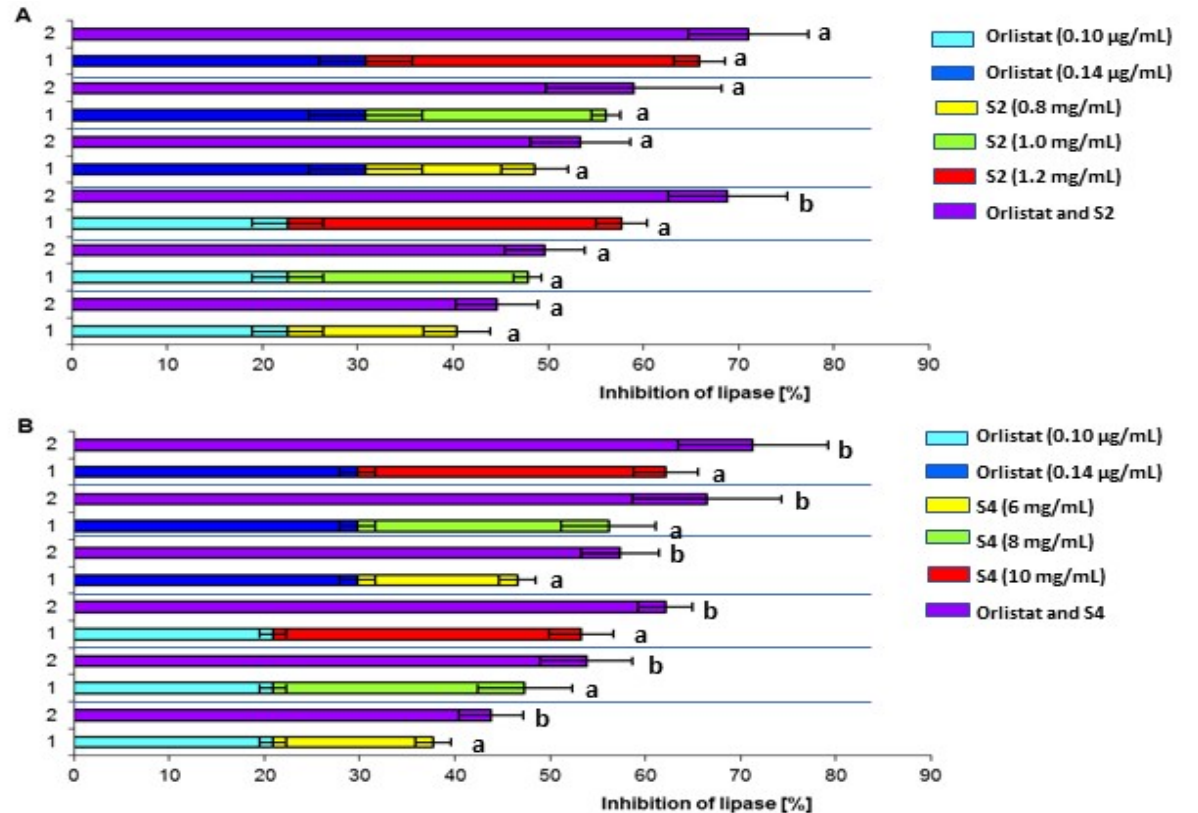
Figure 1. Percentage lipase inhibition by unripe fruits (S2) and orlistat (O)—( A ), and ripe fruits (S4) and orlistat—( B ) at various concentrations; 1—inhibition of lipase by single inhibitors; 2—inhibition of lipase by mixture of inhibitors; values are means ± SD ( n = 3). Different letters denote significant differences ( p < 0.05) between the sum of the percentage inhibition caused by individual inhibitors (1) and the inhibition caused by a mixture of these inhibitors (2).